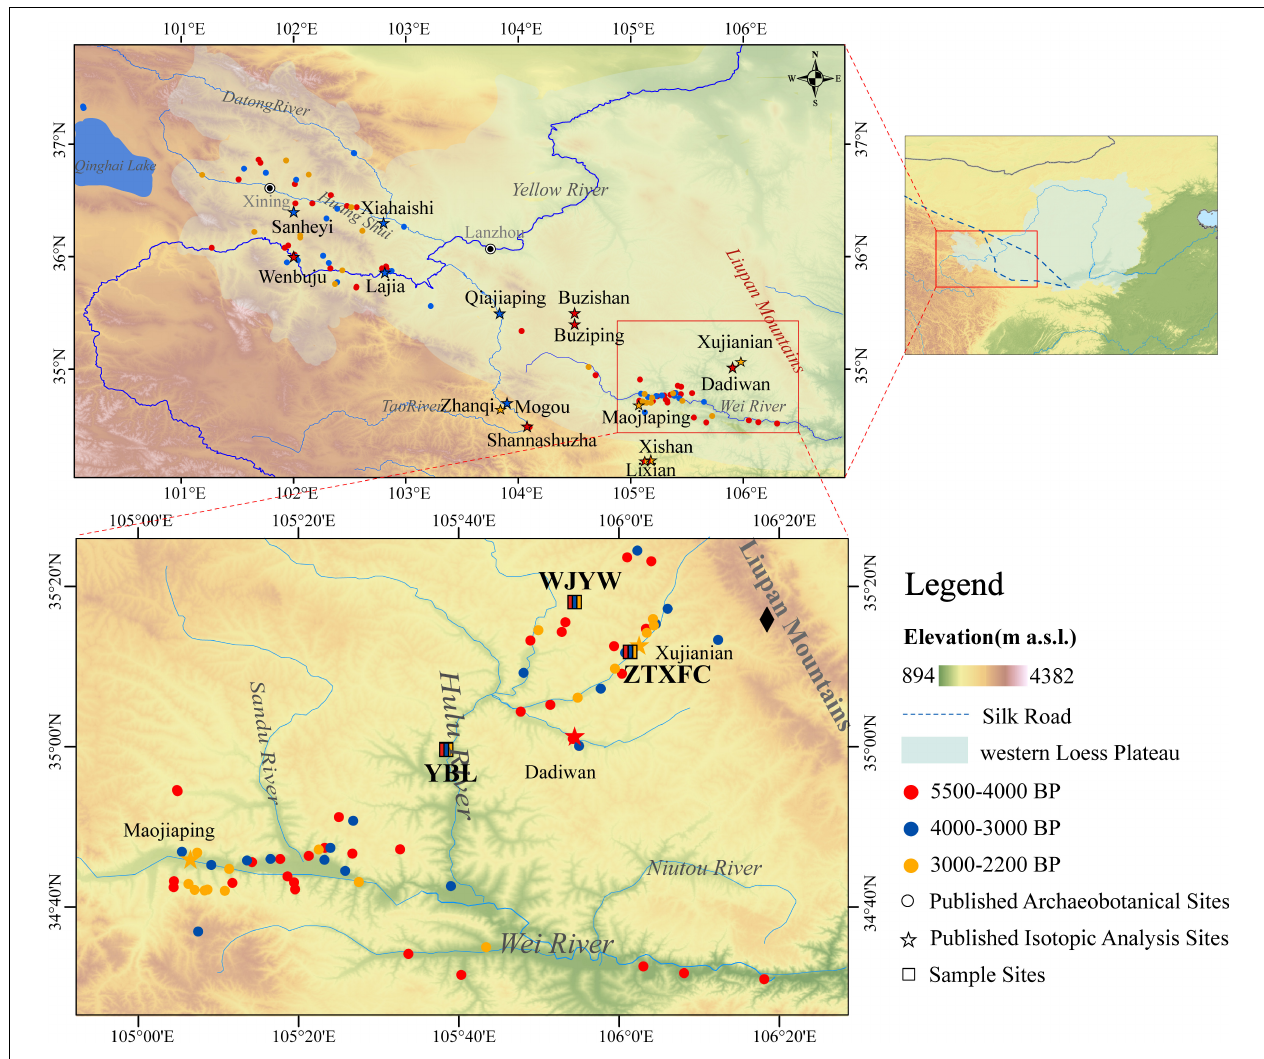
FIGURE 1 | Map showing the location of the study area and the distribution of sites with published archaeobotanical and isotopic analysis, as well as the locations of sample sites in the